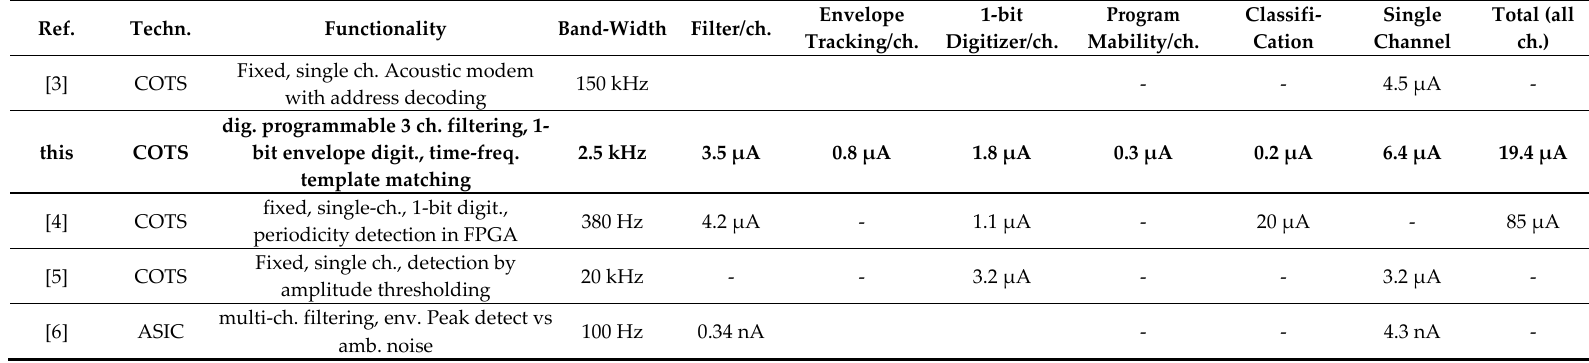
Table 1. Current consumption breakdown ( V CC = 1.8 V), and comparison to the related acoustic wake-up designs. (Legend: - feature not present; feature present,  but consumption not